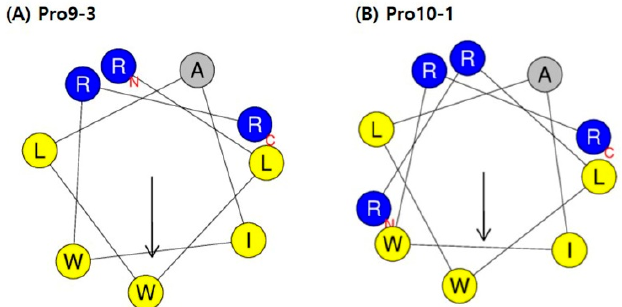
Figure 1. Helical-wheel diagrams of ( A ) Pro9-3 and ( B ) Pro10-1 using HeliQuest online tool [32]: Positively charged amino acid residues are shown in blue, negatively charged residues are in red, and hydrophobic residues are in yellow at the bottom of the wheel. Alanine (A) is shown in gray. The arrows indicate the helical hydrophobic moment.